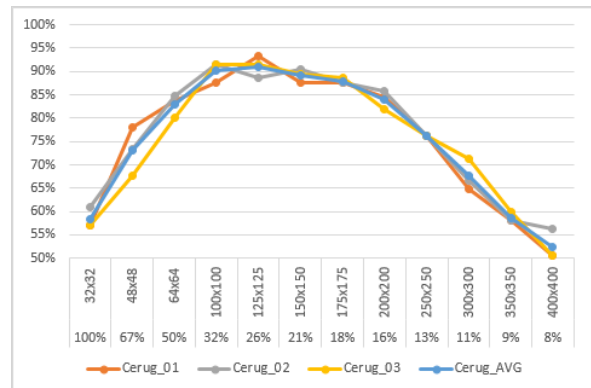
Figure 10. Results of three tests per patch size using the ResNet-18 model and the CERUG-CN